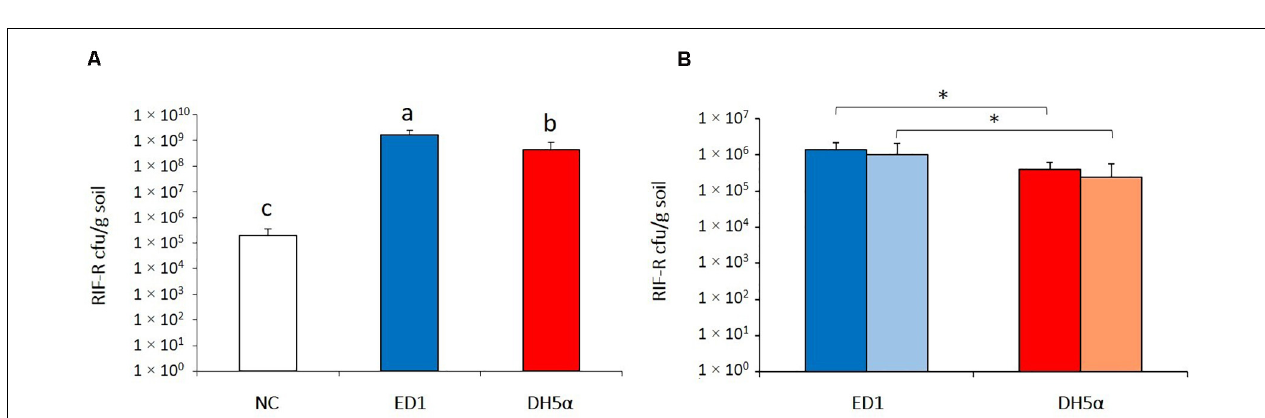
FIGURE 3 | Transformation frequencies of E. coli strains ED1 and DH5 α using different types of water: (A) Milli-Q water, (B) ALW, and (C) treated wastewater (WW).